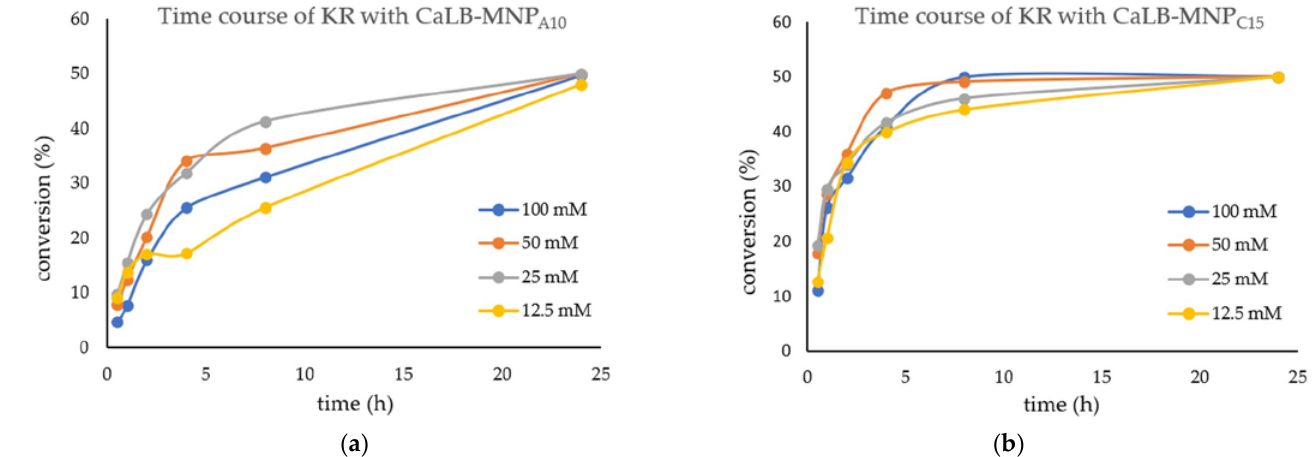
Figure 3. Time course of the kinetic resolution of racemic 4-(morpholin-4-yl)butan-2-ol ( ± )- 1 with vinyl acetate in batch mode used as a biocatalyst, ( a ) adsorptively immobilized CaLB-MNP A10 ,